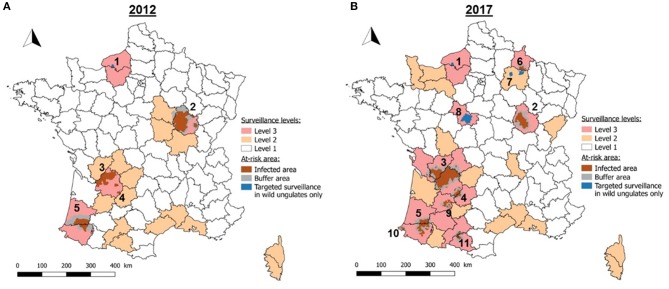
Changes in surveillance levels and at-risk areas between 2012 (A) and 2017 (B) (1: Brotonne-Mauny forest; 2: Côte-d'Or; 3: Dordogne/Charente/Charente-Maritime/Haute-Vienne/Corrèze/Gironde; 4: Dordogne/Lot; 5: Béarn; 6: Ardennes/Marne; 7: Marne (Reims Mountain); 8: Loir-et-Cher (Sologne); 9: Lot-et-Garonne; 10: Pays Basque; 11: Ariège/Haute-Garonne).